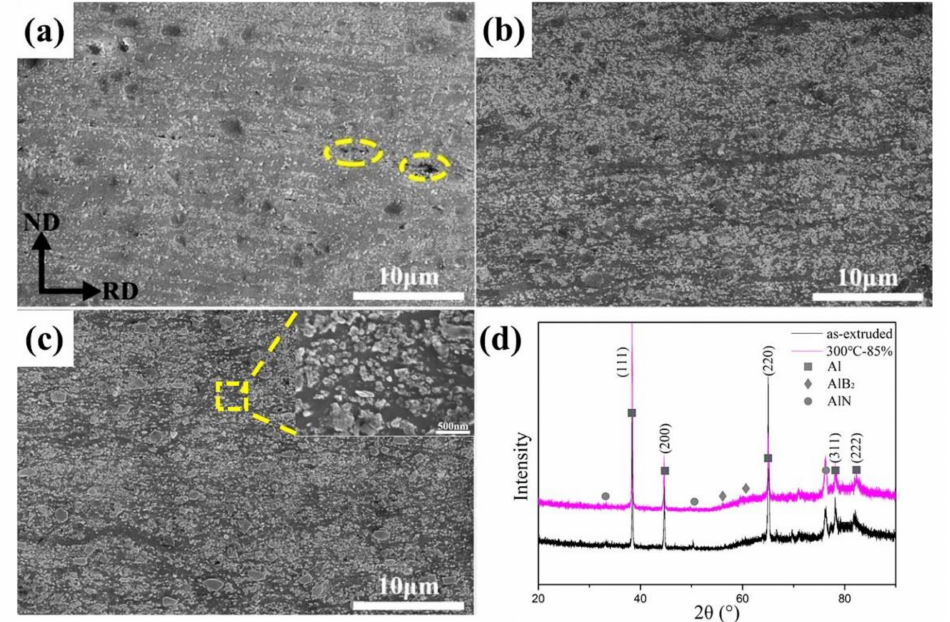
Figure 3. Microstructures and phase identification of AlN / Al nanocomposites with di ff erent rolling